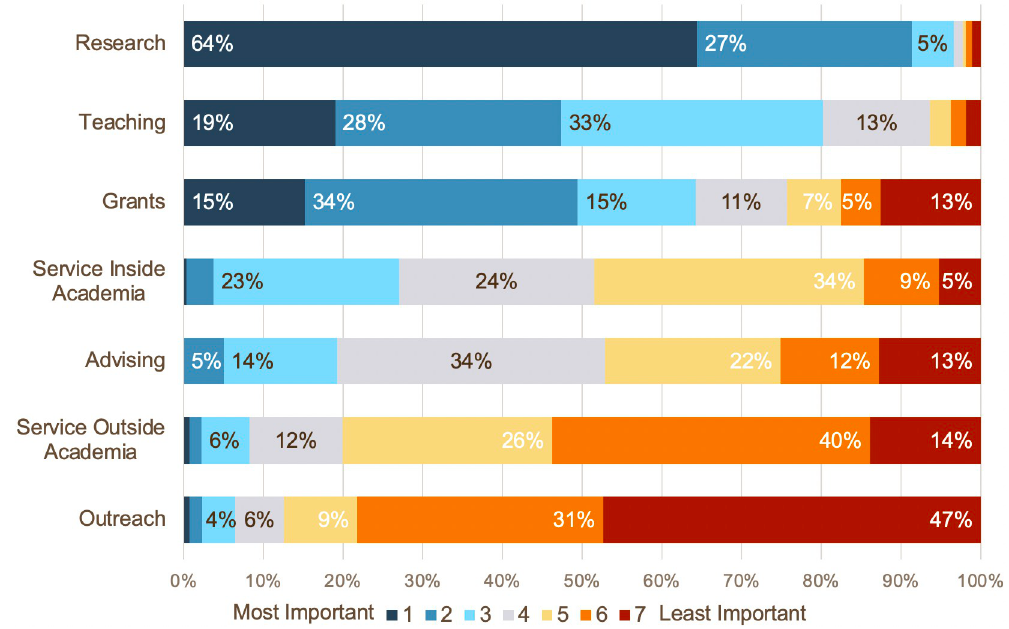
Fig 1. Survey respondents’ ranking of factors in response to the question: “Which of the following do you think is the most important for your review, promotion or tenure?”. Ranked in order of 1 (most important) to 7 (least important). Factors are ordered in their overall rate of importance (i.e., percent of respondents indicating a 1, 2, or 3).